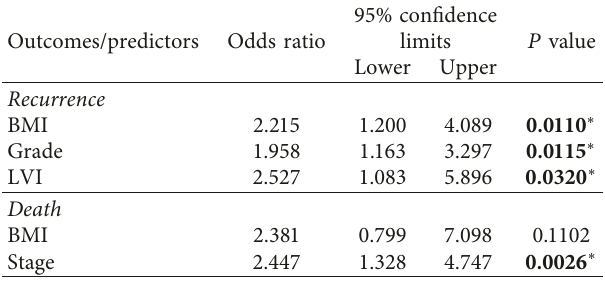
Stage 2.447 Statistical significance at